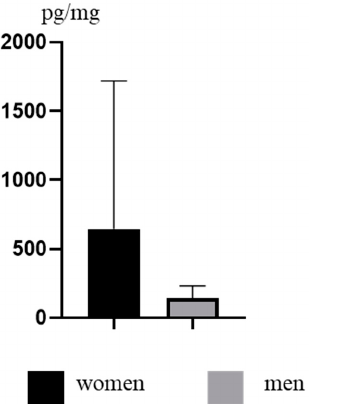
Figure 3. Mean concentration levels (±SD) of TCS in men and women.